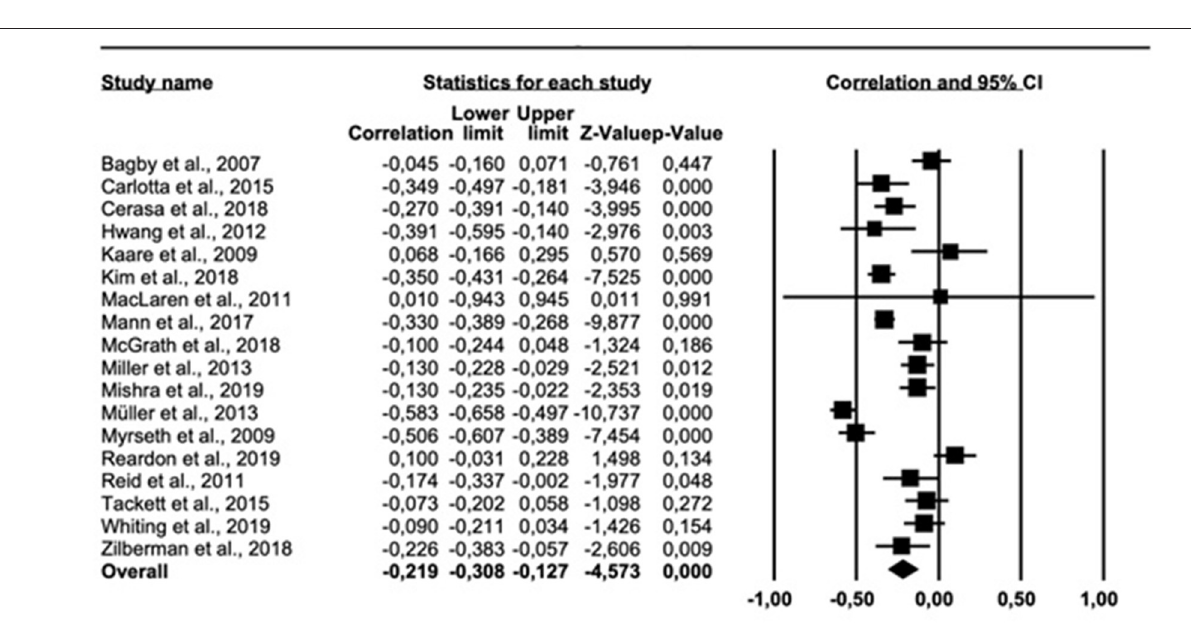
suggested an adjusted effect size of − 0.256 (95% CI = − 0.344, −